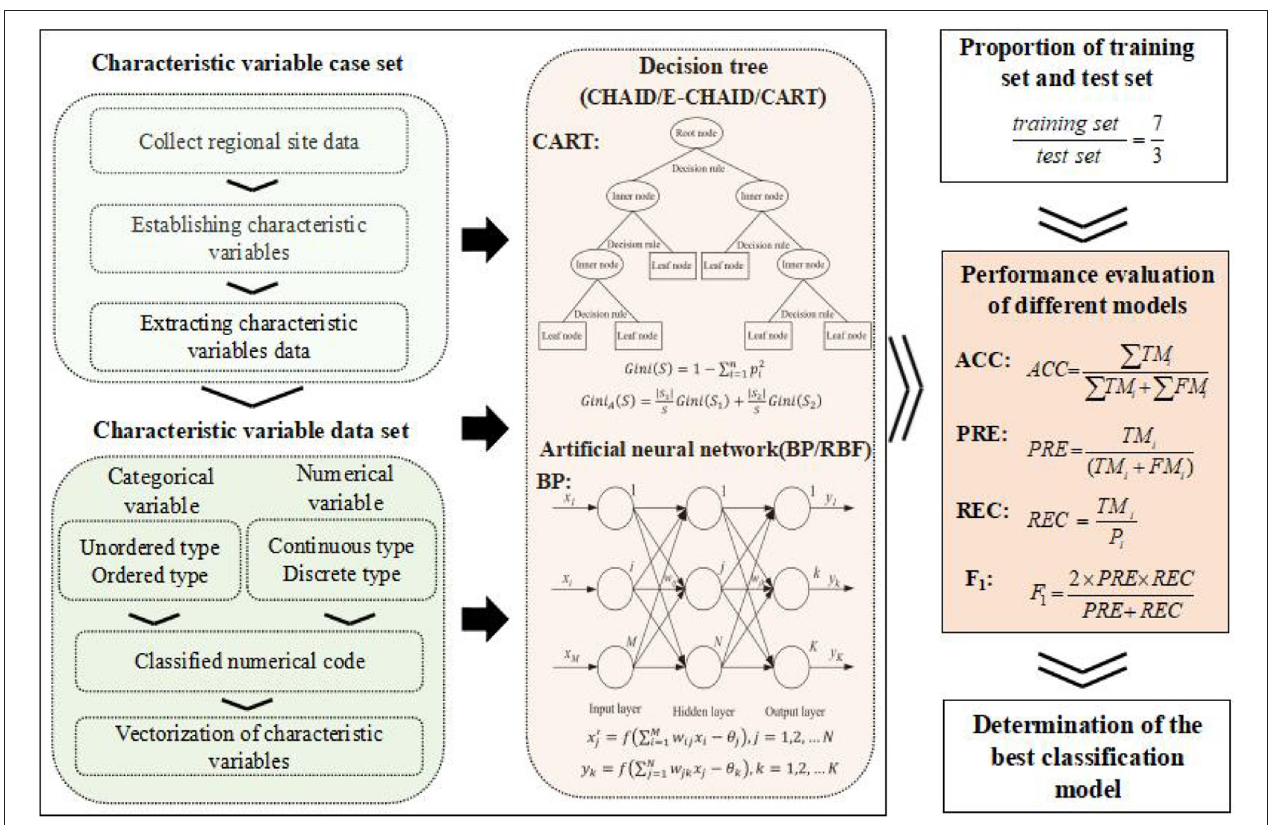
FIGURE 1 | Technical route of RMCM prediction in regional